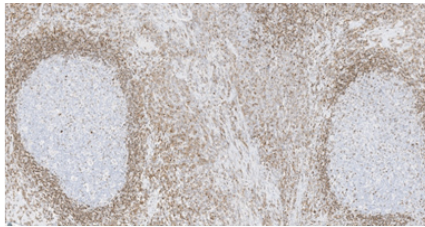
Figure 5: Lymphoid follicles lack Bcl-2.